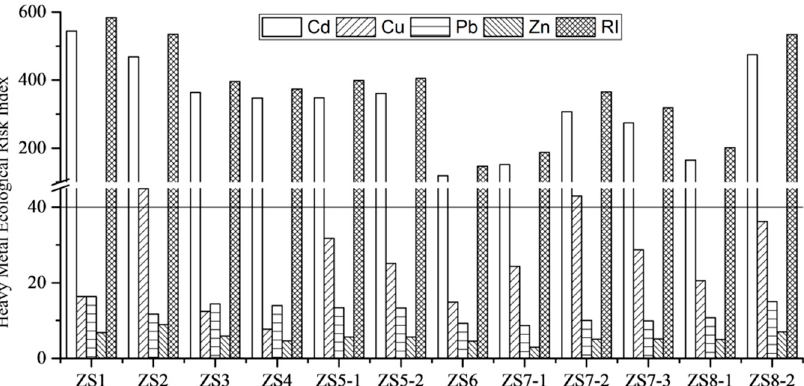
Figure 3. Potential ecological risk (EI) and comprehensive potential ecological risk (RI) of heavy metal elements Cd, Pb, Cu, and Zn in the soil.